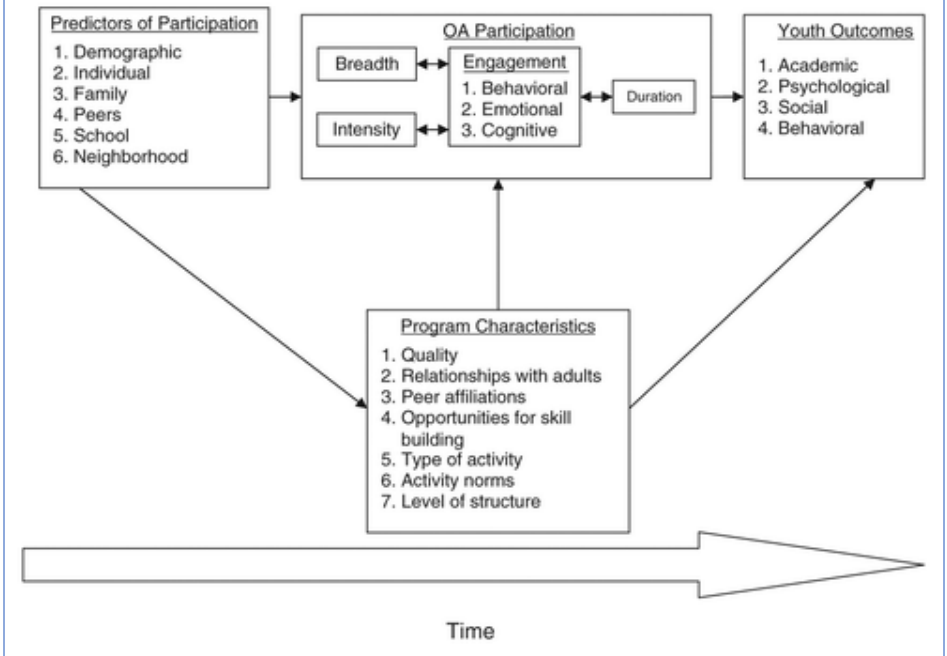
Figure 1. The Conceptual Model of Participation in Organized